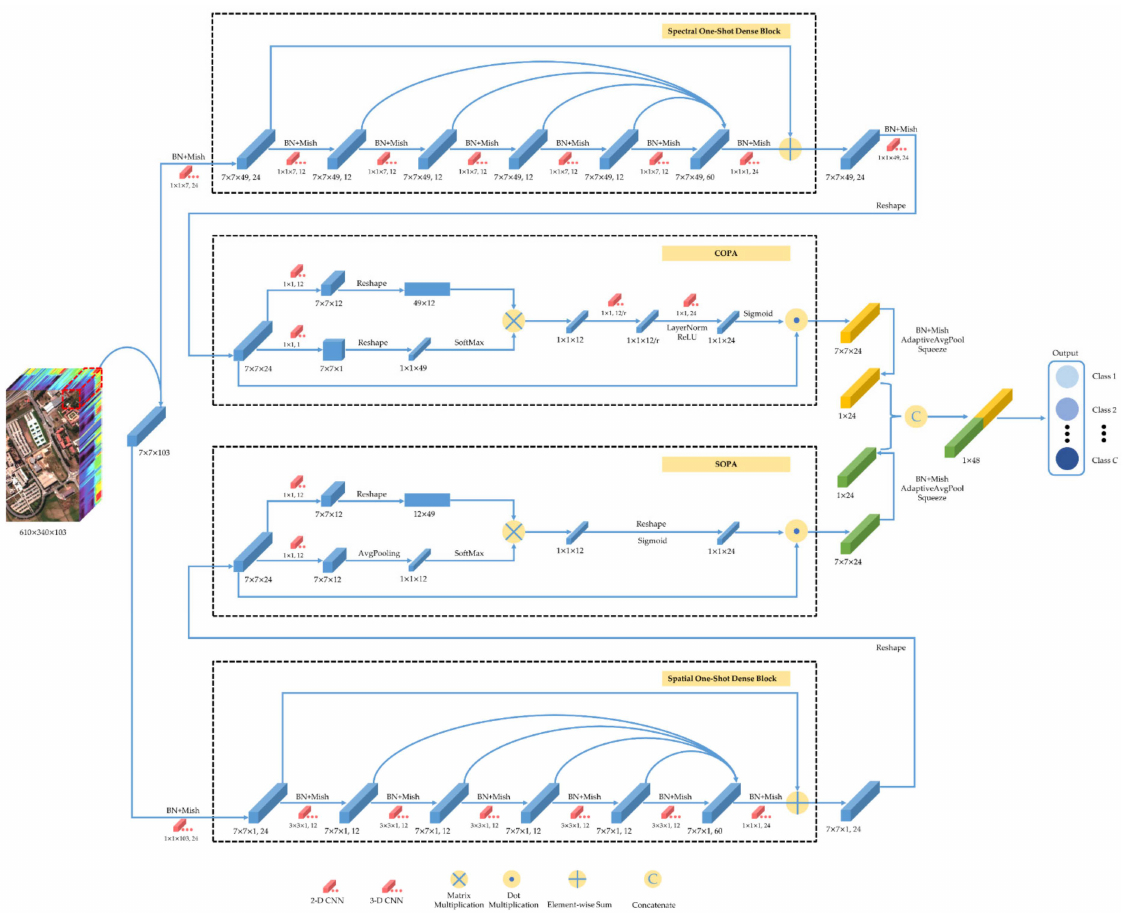
Figure 6. The structure of the proposed